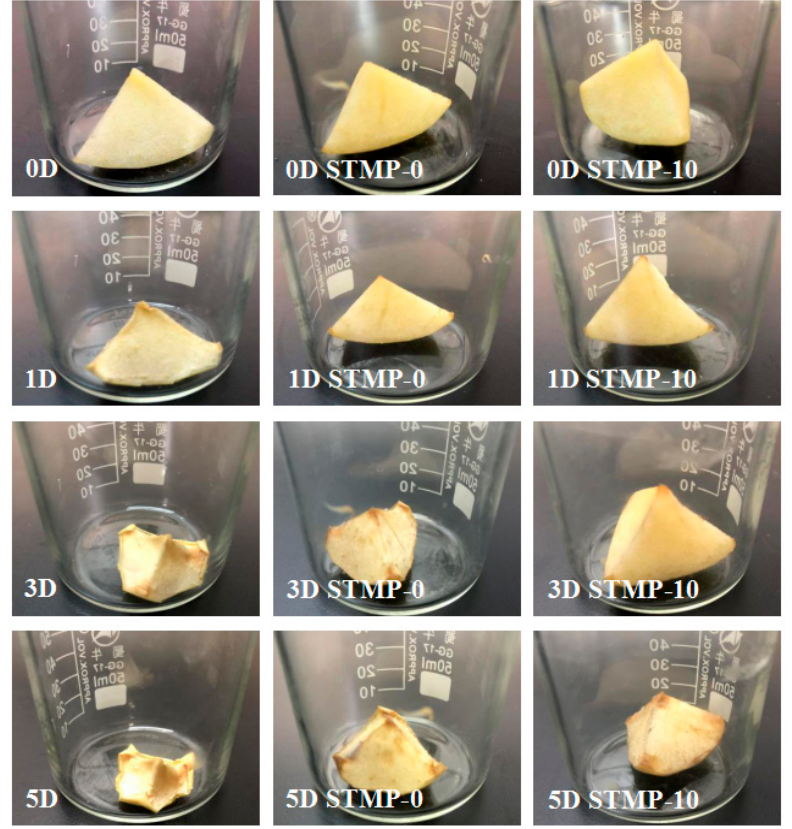
Figure 8. Appearance (oxidation and dehydration status) evolution of apple sample exposed to air (left column), stored in beaker sealed with hemicellulose film (middle column) and STMP crosslinked hemicellulose film (right column) with time (rows 1–4 corresponding to 0 d, 1d, 3 d and 5d, respectively), showing the potential of modified hemicellulose film in fruit packaging.